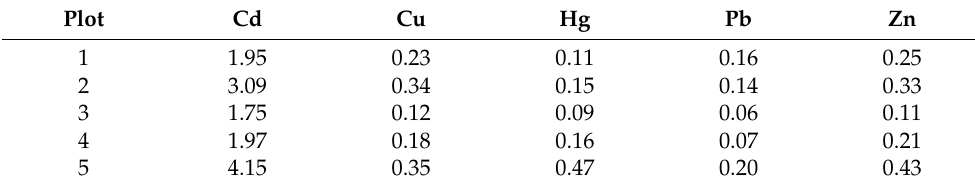
Table 3. The contamination factor (CF) for heavy metals in surface sediments from five plots in Lake